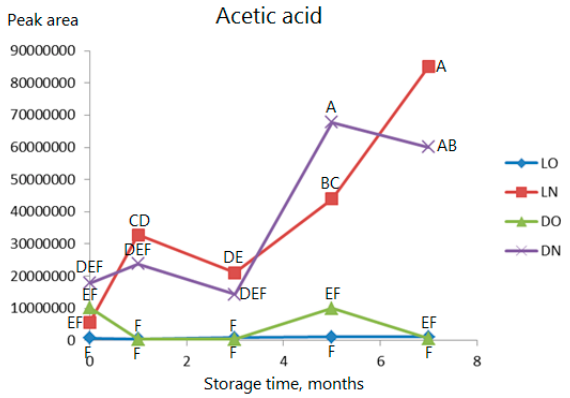
Figure 7. As Figure 3 but data for acetic acid. Observations marked with the same letter are not significantly different ( p > 0.05).